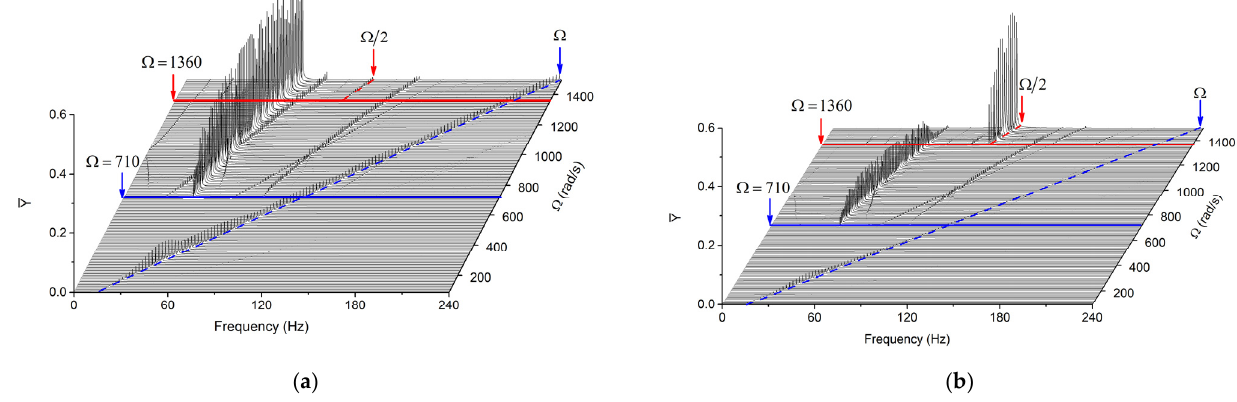
Figure 13. Cascade maps of Y-displacements: ( a ) Rotor; ( b ) Bearing.